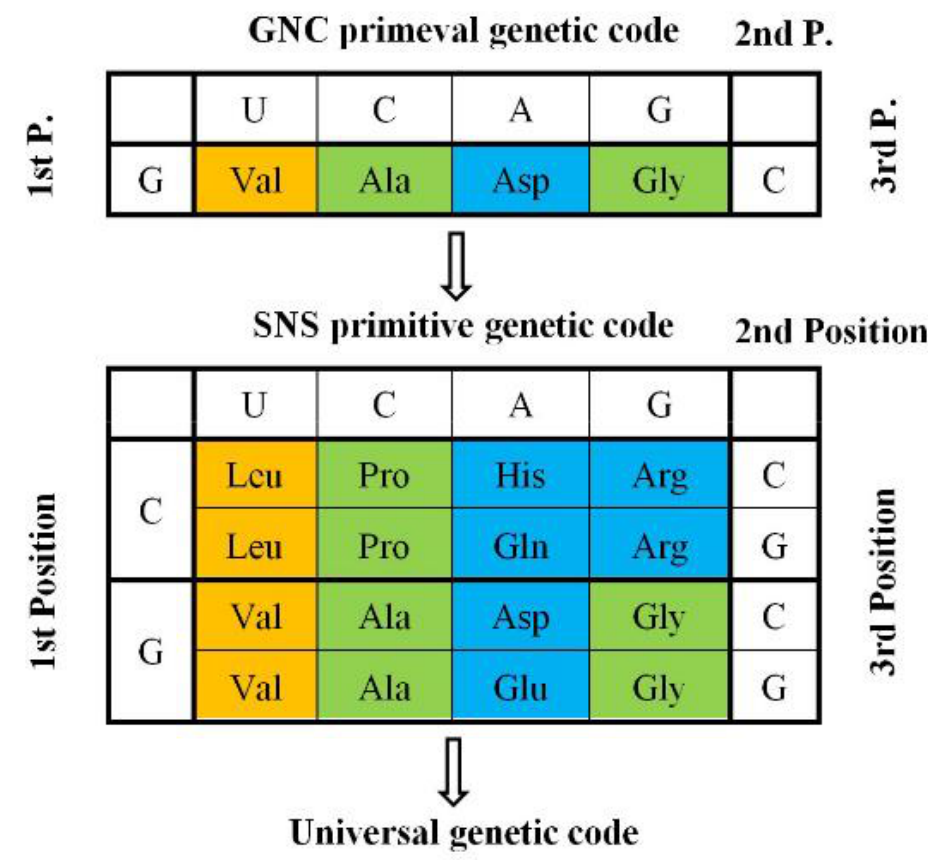
Figure 3. GNC-SNS primitive genetic code hypothesis [7]: The hypothesis, which was proposed based on formability of entirely new water-soluble globular protein, suggests that the universal genetic code originated from GNC primeval genetic code via SNS primitive genetic code. Amino acids written in brown, green, blue boxes indicate hydrophobic, intermediate, and hydrophilic amino acids, respectively.